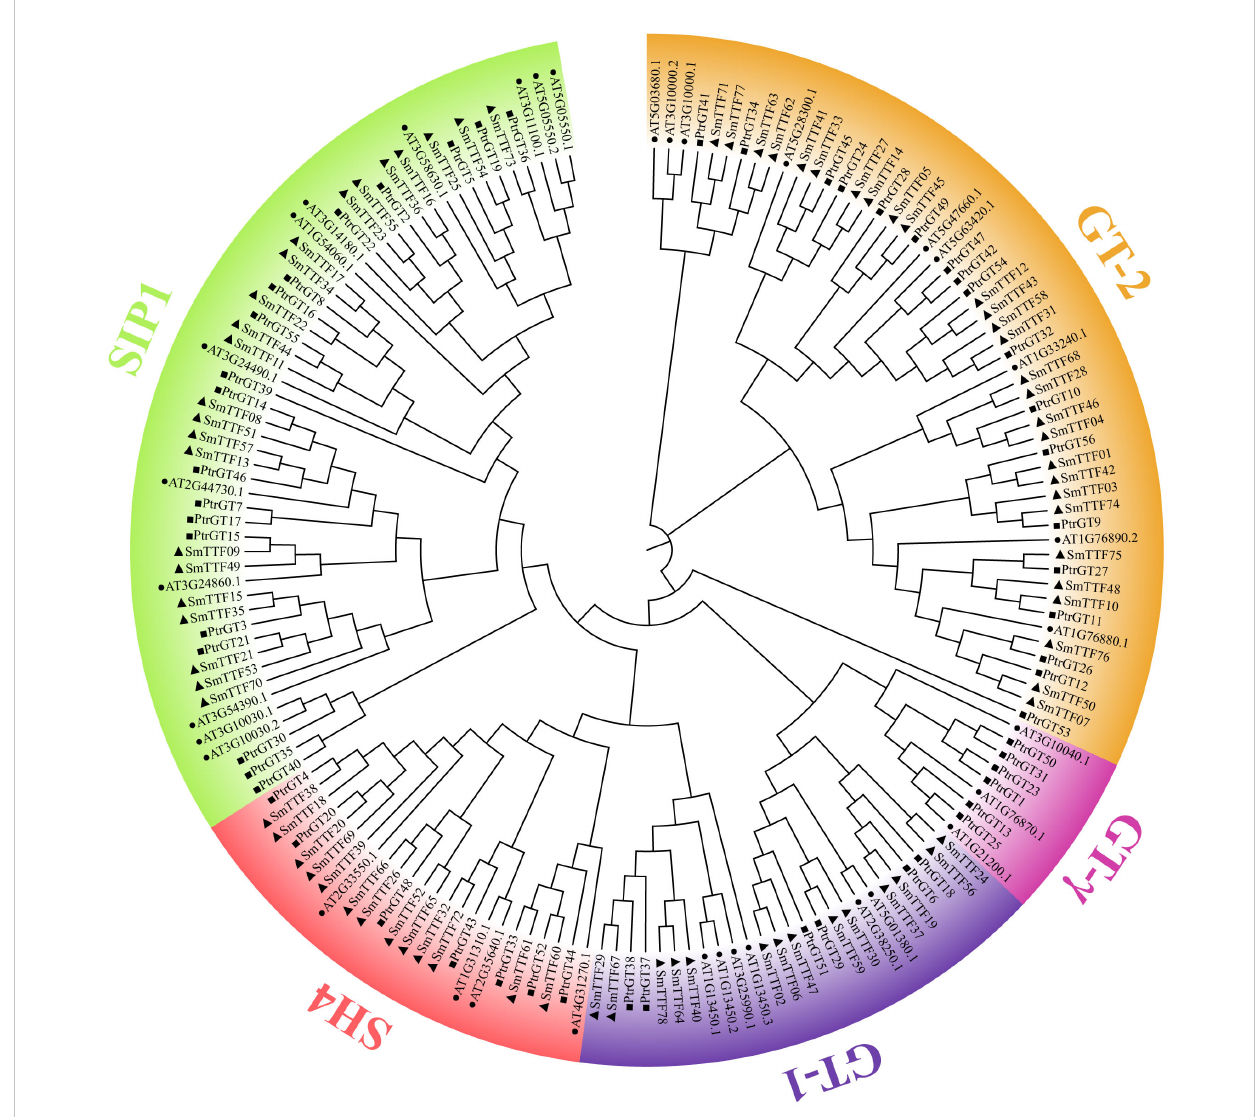
FIGURE 1 Phylogenetic tree of trihelix proteins in S. matsudana, A. thaliana and P. trichocarpa. Different colored branches represent different subfamilies. S. matsudana , A. thaliana and P. trichocarpa are marked as triangles, circles and squares,